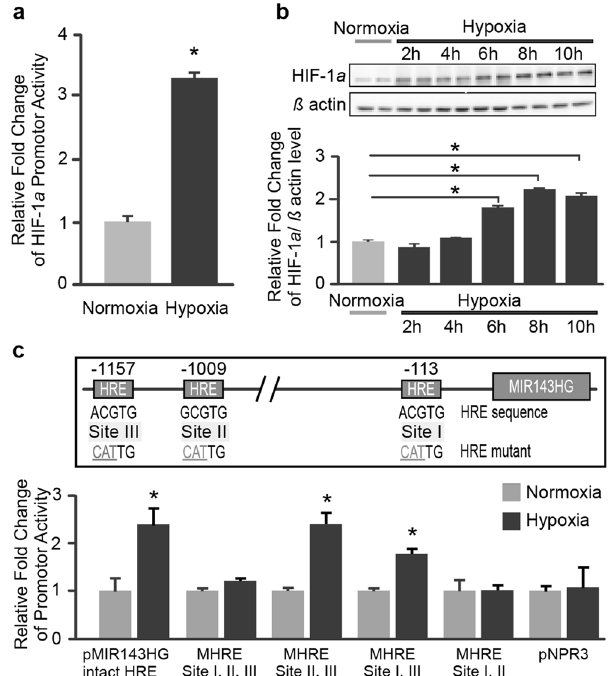
Figure 3. MIR-143HG promoter activity is modulated by hypoxia. ( a ) Hypoxic treatment increases the promoter activity of HIF1a. ( b ) Western blot analysis of HIF-1a protein level in HCMa after hypoxic treatments ( c ) Mutagenesis analyses of MIR143HG promoter demonstrate the essential roles of hypoxia response elements in hypoxia induced transcriptional activation for MIR143HG. The mutated HRE sites are indicated by underlined gray fonts. No change in the NPR3 promoter activity was observed after hypoxia treatment. Data are presented as mean ± SD, n = 3, Student’s t test, * p <